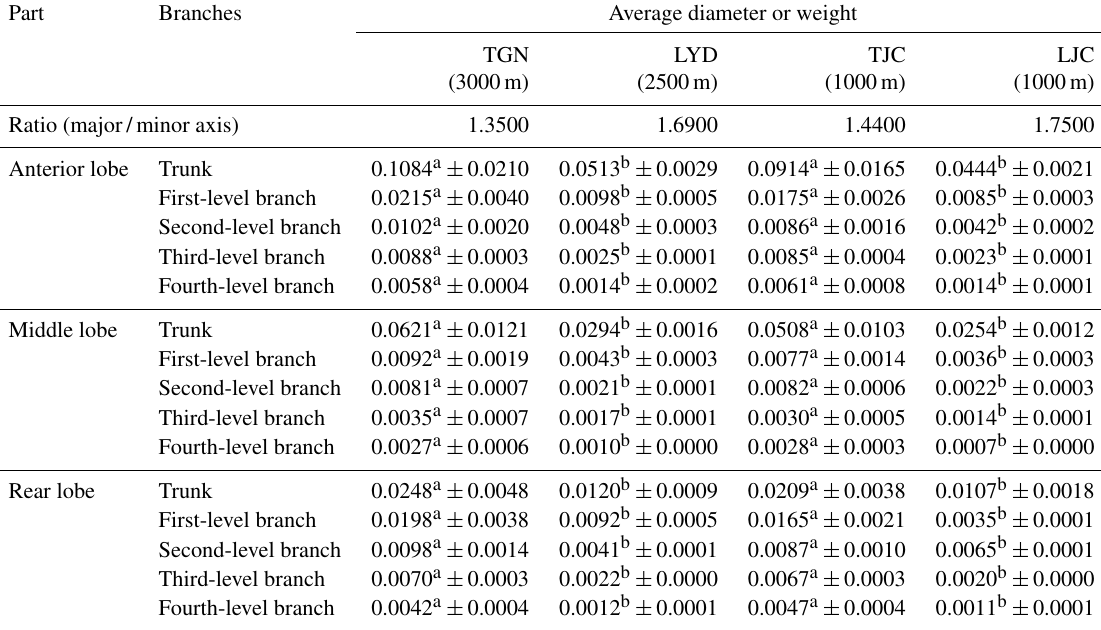
Table 2. Diameters of the left pulmonary artery of